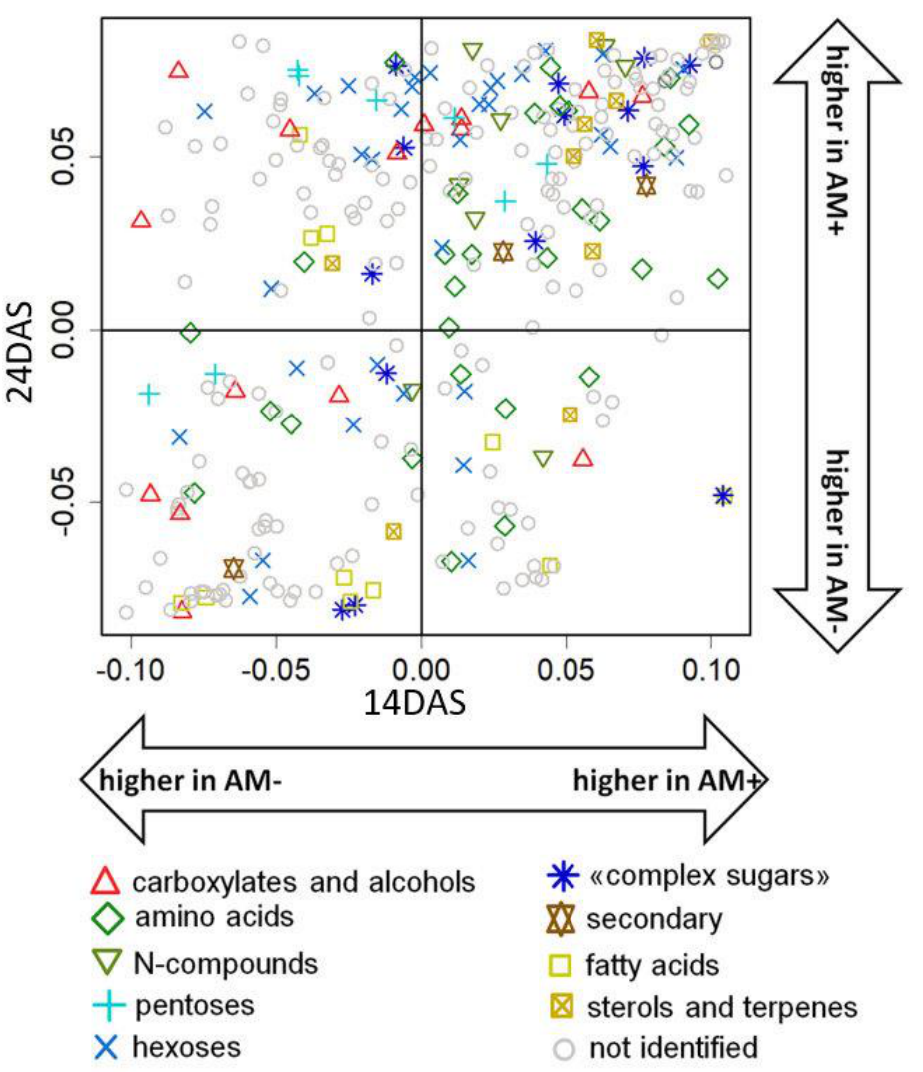
Figure 6. Comparison of mycorrhization effects at 14 and 24 DAS. SUS plot in the space of the loadings from two OPLS-DA models for discrimination of mycorrhized (AM+) and non-mycorrhized (AM − ) roots at 14 DAS (abscissa) and 24 DAS (ordinate); positive values correspond to higher content at AM+.